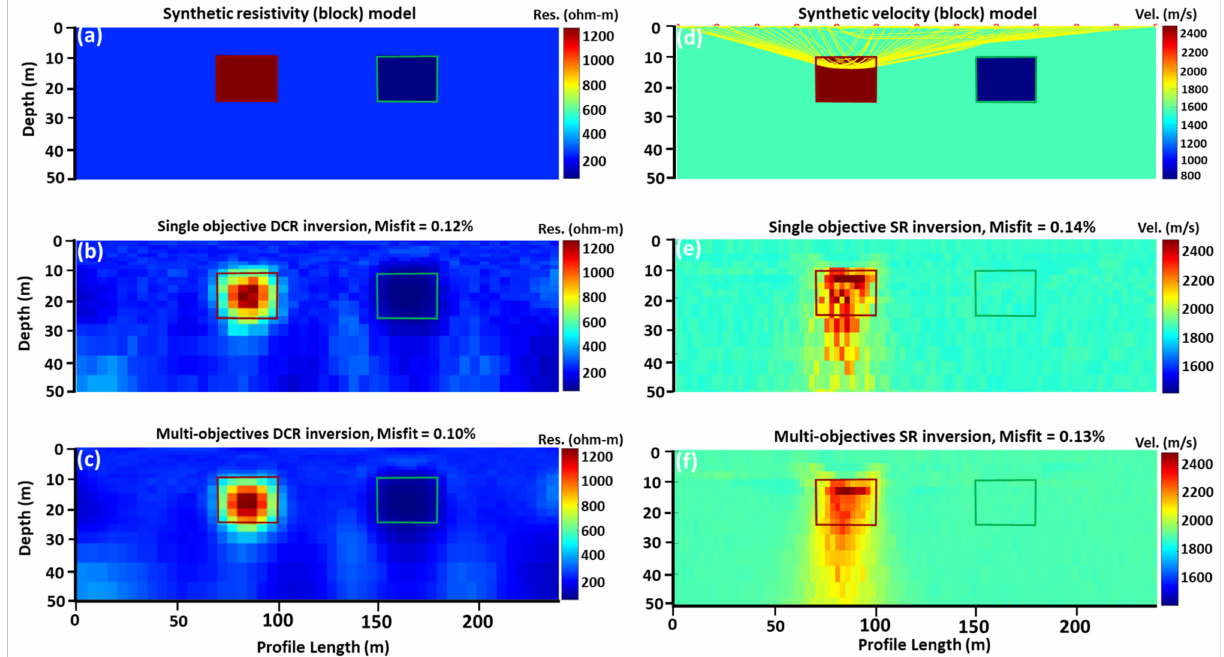
Figure 10. Positive and negative anomaly model inversion using the combined optimization method; ( a ) synthetic dc-resistivity model, ( b ) single objective inverted resistivity model, ( c ) multi-objective inverted resistivity model, ( d ) synthetic velocity model and its ray path coverage, ( e ) single objective inverted velocity model, and ( f ) multi-objective inverted velocity model. The dark red and green lines are used to mark the anomaly